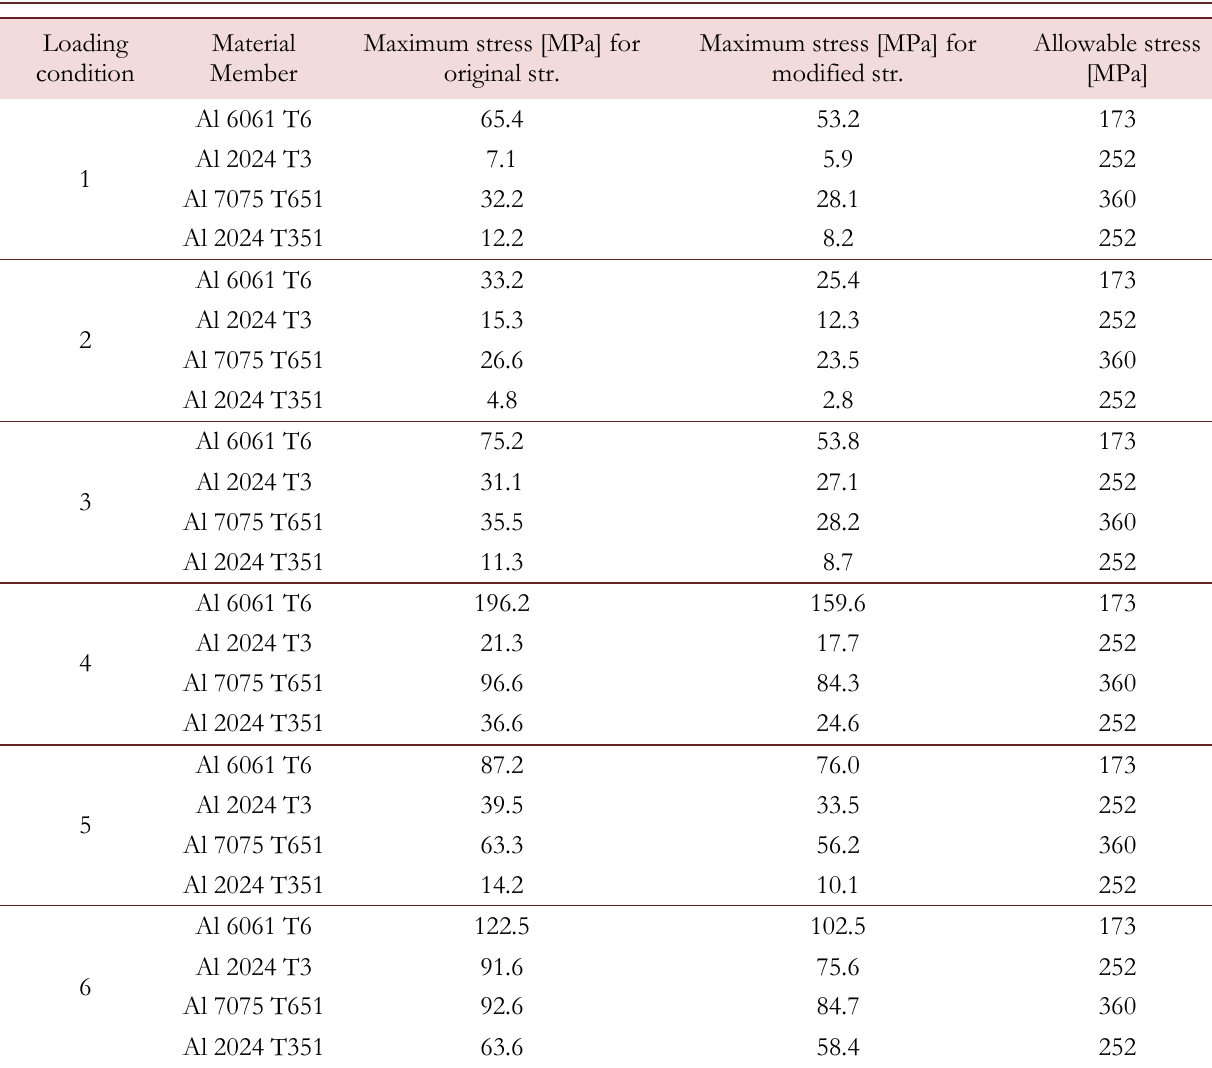
Table 6: Maximum von Mises static stress results in the members of the structure compared with the allowable limits.